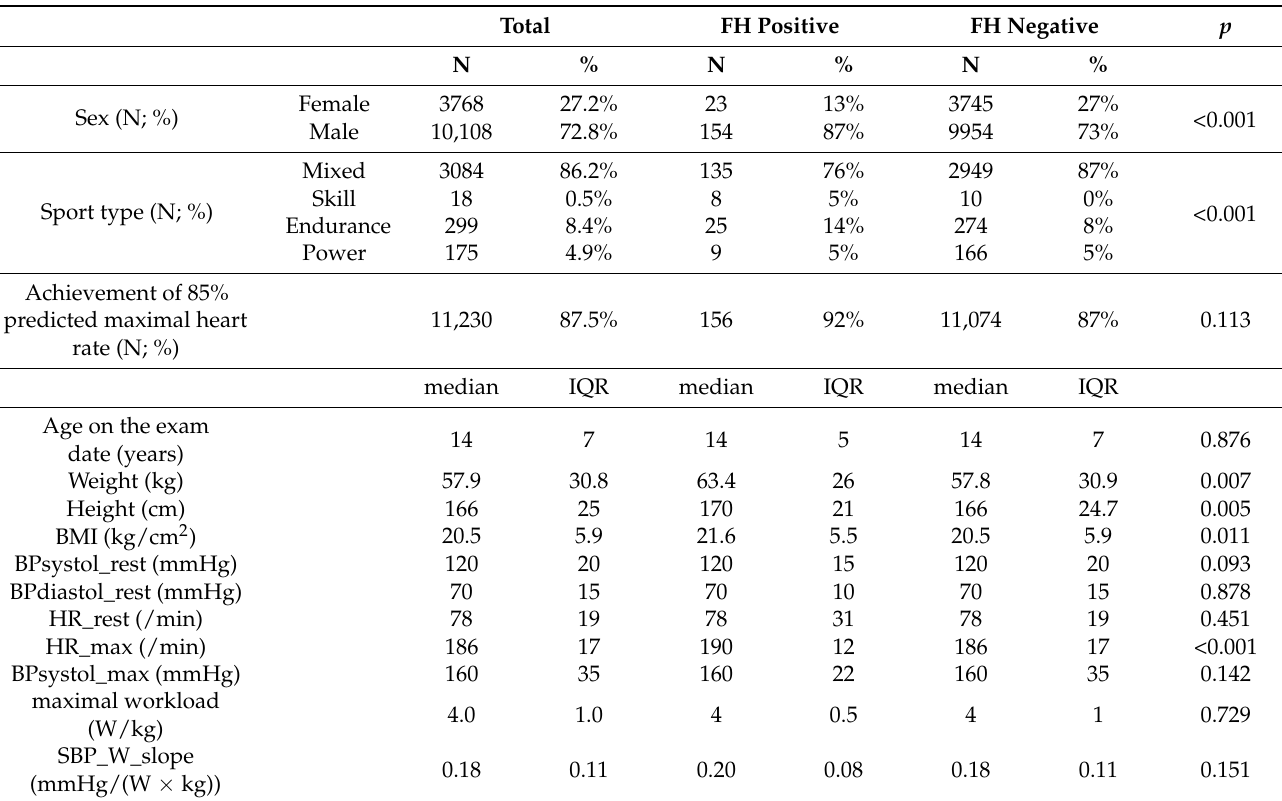
Table 1. Demographics of the entire athlete cohort and stratification by SCD/CVD family history status. The table includes data on sex (female or male), sport type (mixed, skill, endurance,